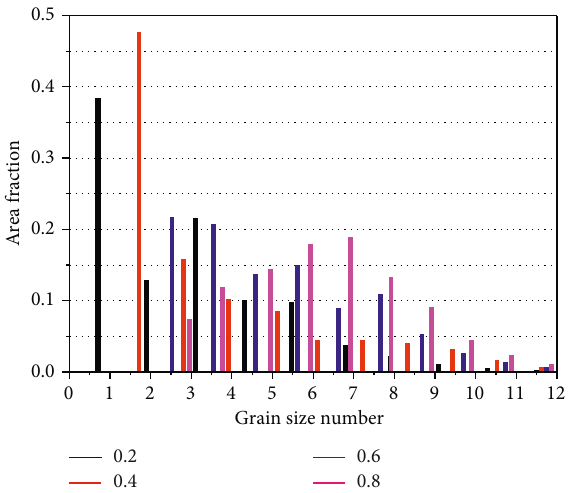
Figure 2: Area fractions of different sizes of grains for specimens deformed at 1050 ° C and 10 − 4 · s − 1